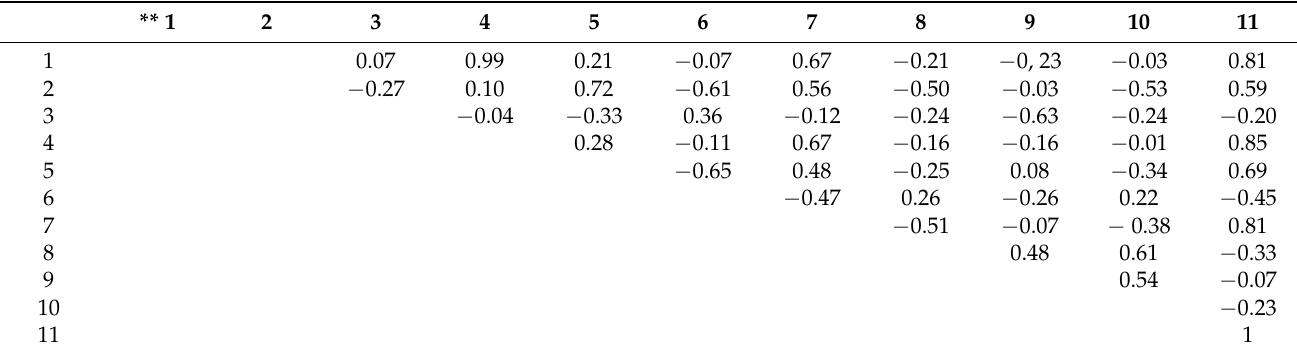
Table 3. Correlation coefficients between environmental state indicators *.